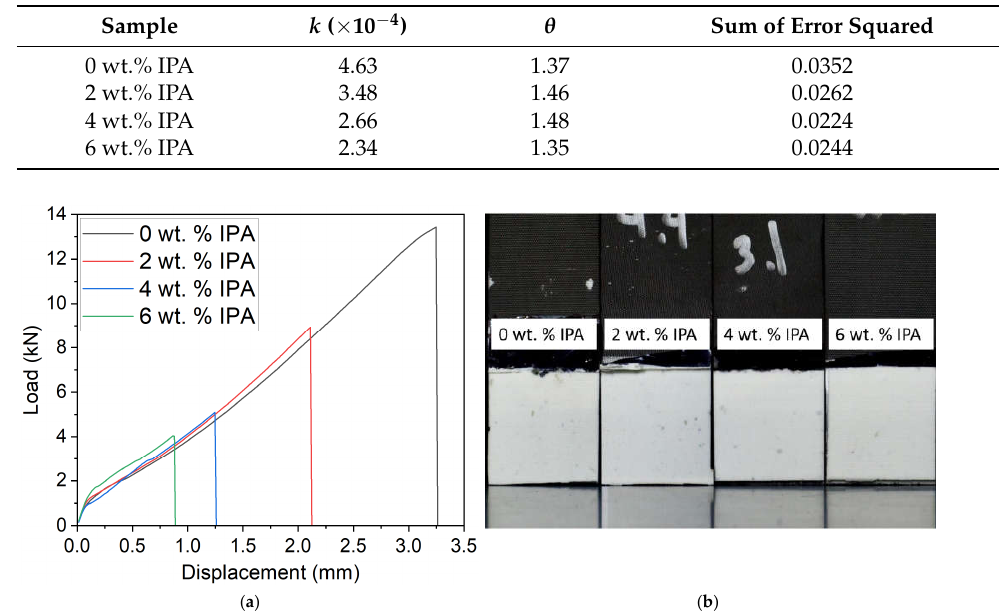
Figure 4. ( a ) Load–displacement curves of the specimens #1 in Table 2 for each sample type; ( b ) failure surfaces for the specimens represented in the load–displacement curves in Figure